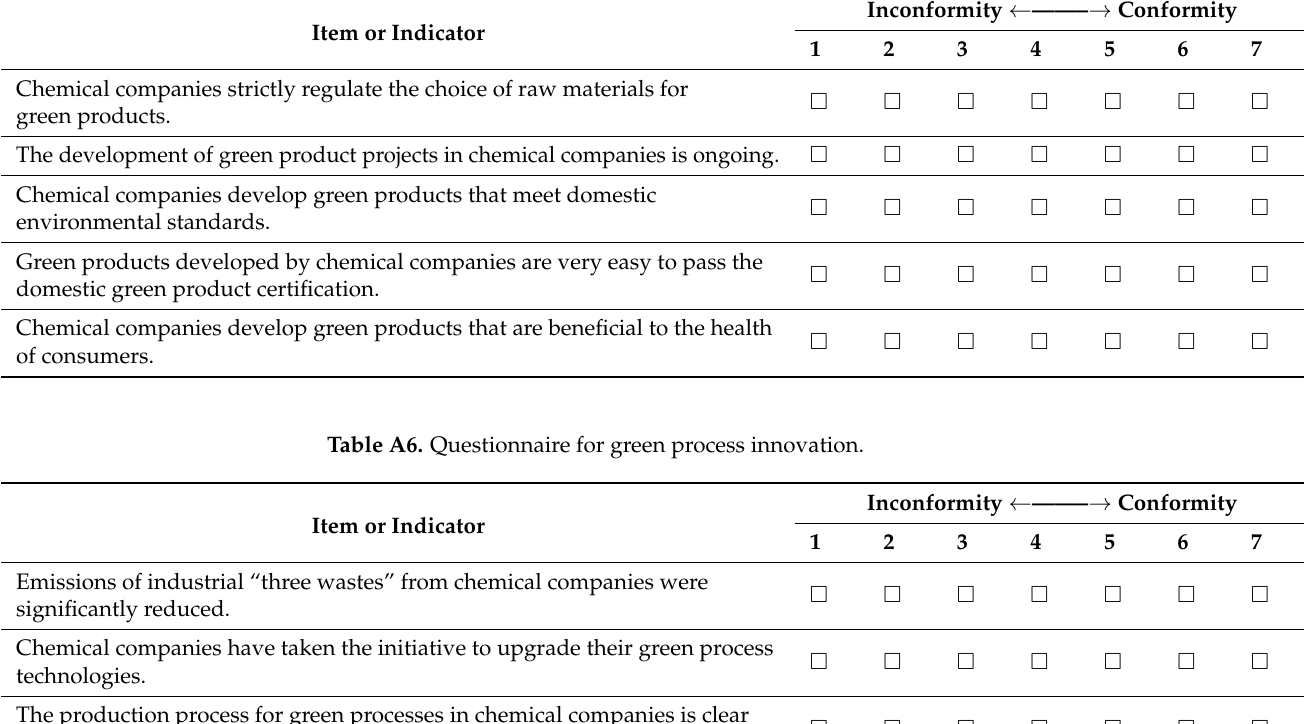
Table A5. Questionnaire for green product innovation. Item or Indicator